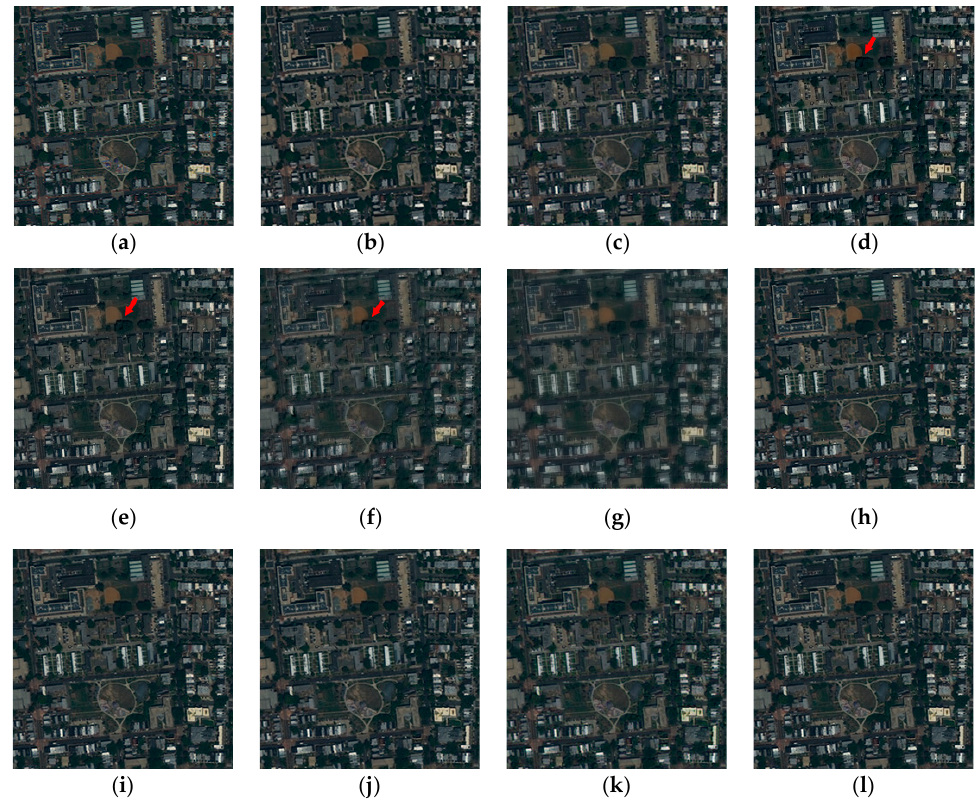
Figure 6. Fused images of different methods on WorldView-2 dataset. ( a ) ground truth; ( b ) our model; ( c ) PNN; (d) BDSD; ( e ) GSA; ( f ) Indusion; ( g ) ATWT-M3; ( h ) TFNet; ( i ) PNN+; ( j ) DRPNN; ( k ) PanNet; and ( l ) MSDCNN.